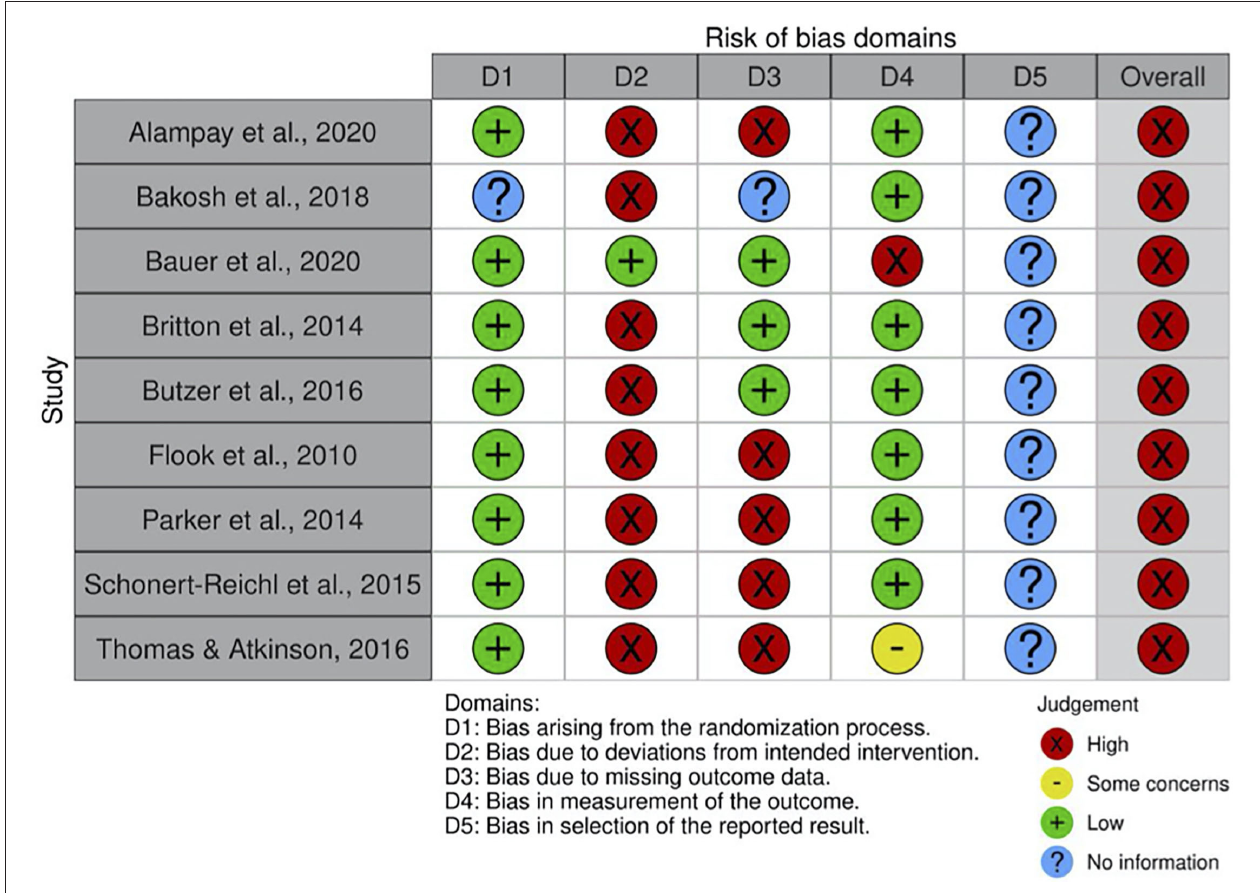
FIGURE 2 | Risk of bias graph across randomized controlled